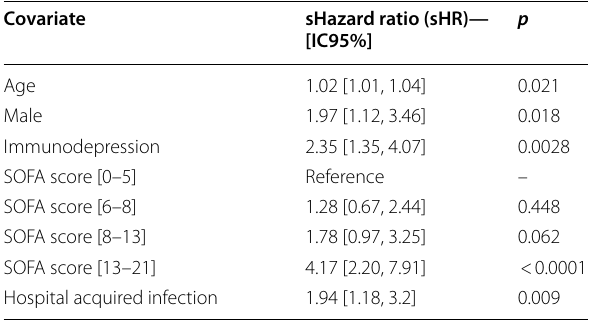
Table 4 Mortality associated risk factors after propensity score-based weighting and multivariate analysis with a Cox proportional hazards model for time-dependent variable after weighting